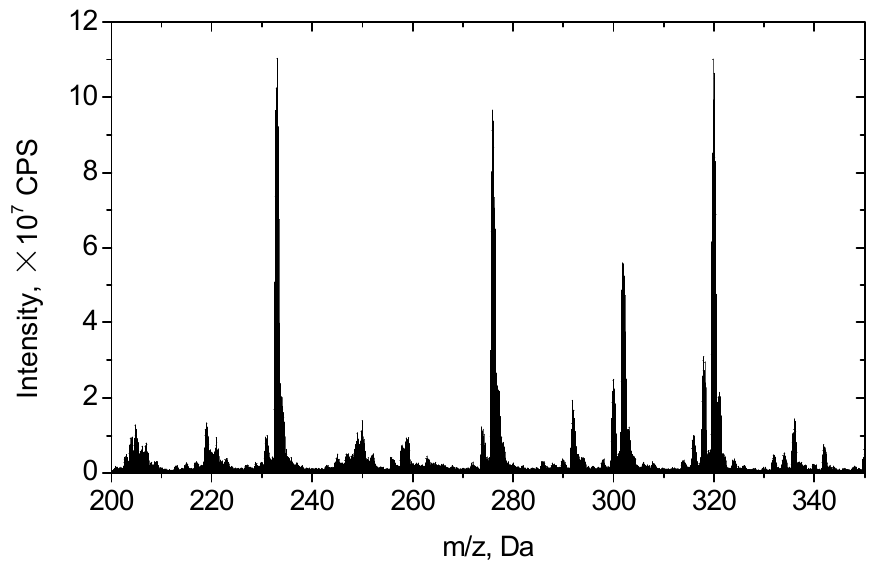
Figure 7. The MS spectra of NOR intermediates detected in sample withdrawn after 1 min of MW/UV reaction.